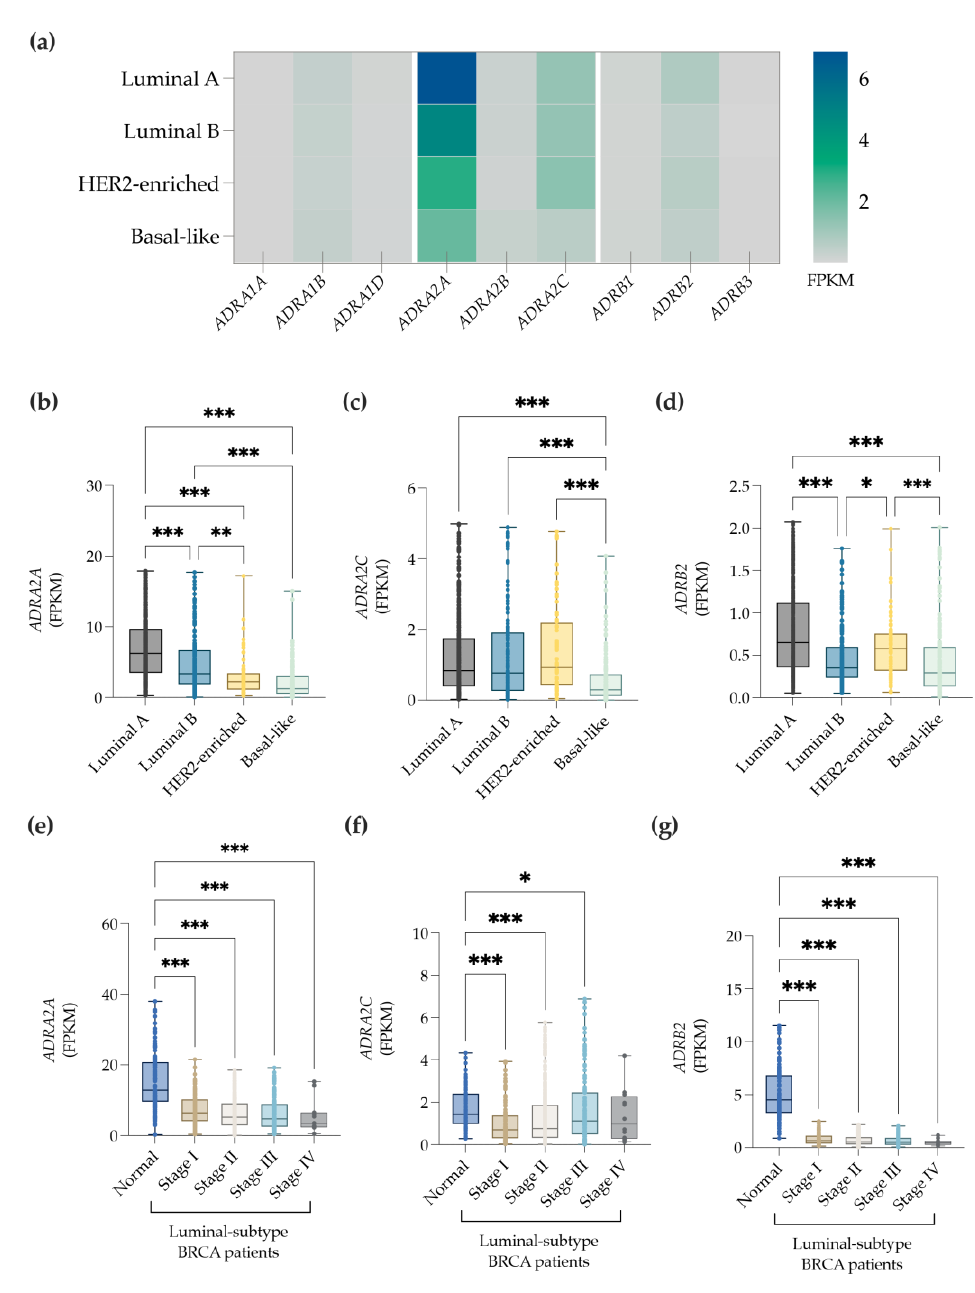
Figure 4. Gene expression profile of ADRs by BC (using the BC dataset included in the TCGA database). ( a ) Heatmap of ADR gene expression in each BC subtype: luminal A, luminal b, HER2-enriched, and basal-like. The tumor gene expression of ADRA2A ( b ), ADRA2C ( c ), and ADRB2 ( d ) are represented in column graphs. The gene expression of ADRA2A ( e ), ADRA2C ( f ), and ADRB2 ( g ) is shown exclusively in the luminal-subtype patients. p -value < 0.05 (*); <0.01 (**), <0.001 (***) was considered statistically significant. BC Tissues Classically, the sources of catecholamine are the adrenal glands (for both NE and EPI) and the terminal nerve fibers (for NE) [46]. However, a great body of evidence has also demonstrated that non-neuronal cells (e.g., immune cells) can express the required ma-